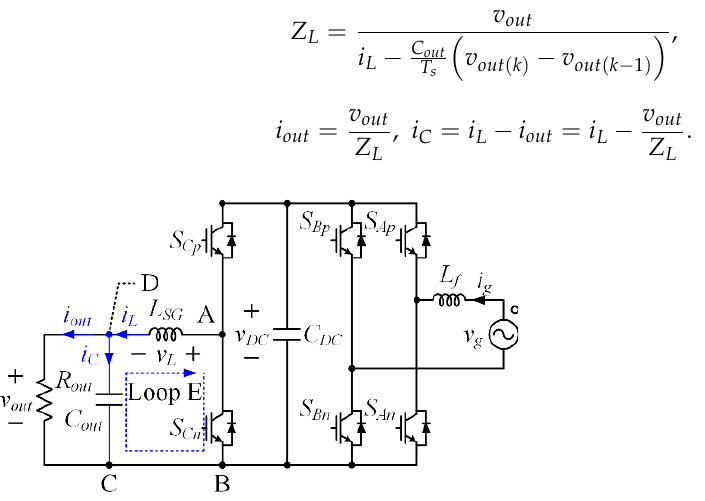
Figure 5. Circuit configuration of integrated OBC for predictive model establishment.